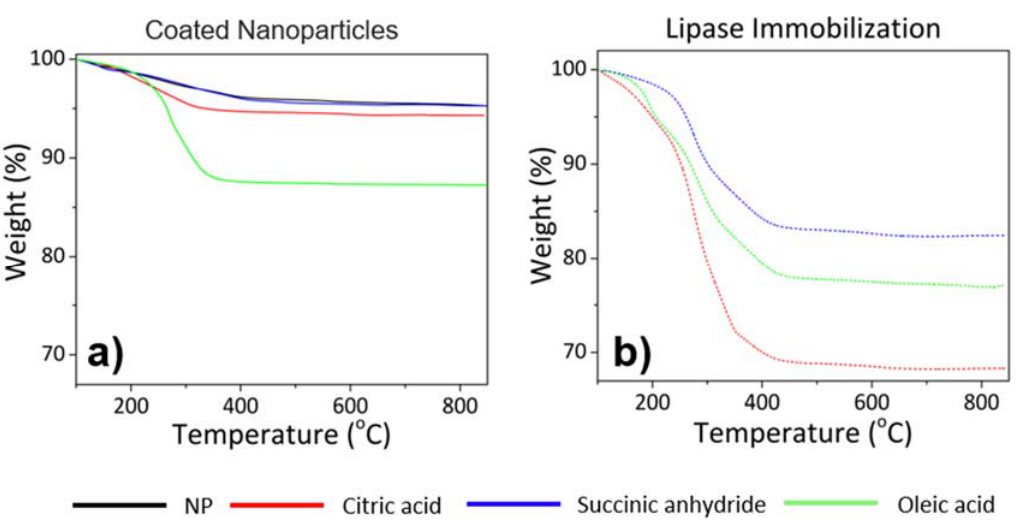
Figure 4. TGA curves of ( a ) CA, SA and OA coated NPs compared with the naked one and of ( b ) CALB EDA @CA-NPs, CALB EDA @SA-NPs and CALB EDA @OA-NPs.